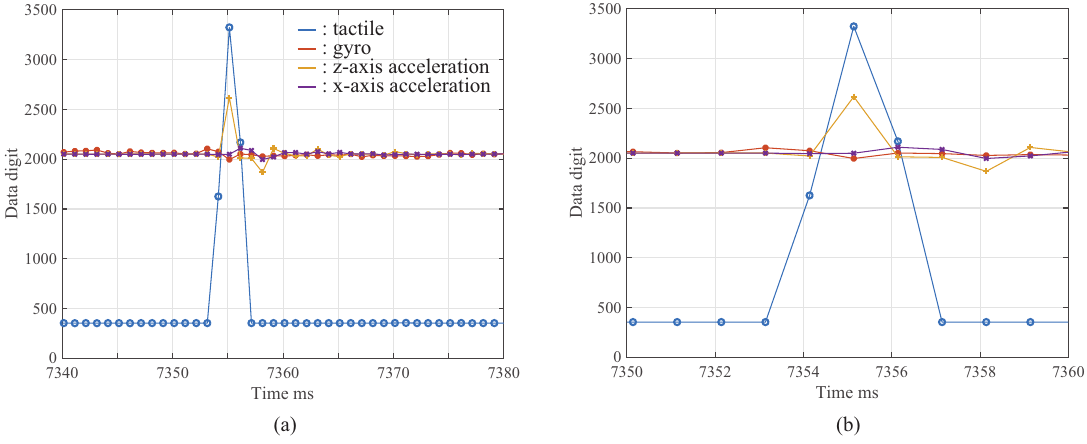
Figure 9. Experimental results with various sensors at 1 kHz: ( a ) shows overall result and ( b ) shows enlarged